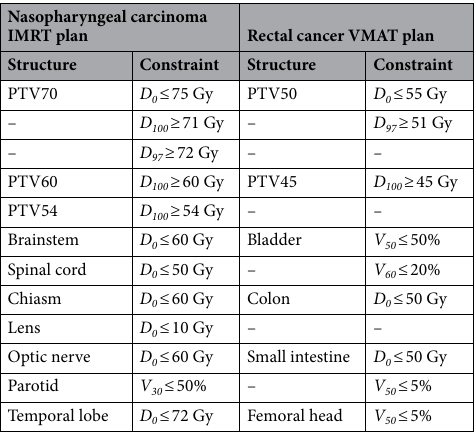
Table 1. The required dose optimization constraints for generating a radiation therapy plan. V x volume receiving greater than x Gy, D y the dose to the highest y % of